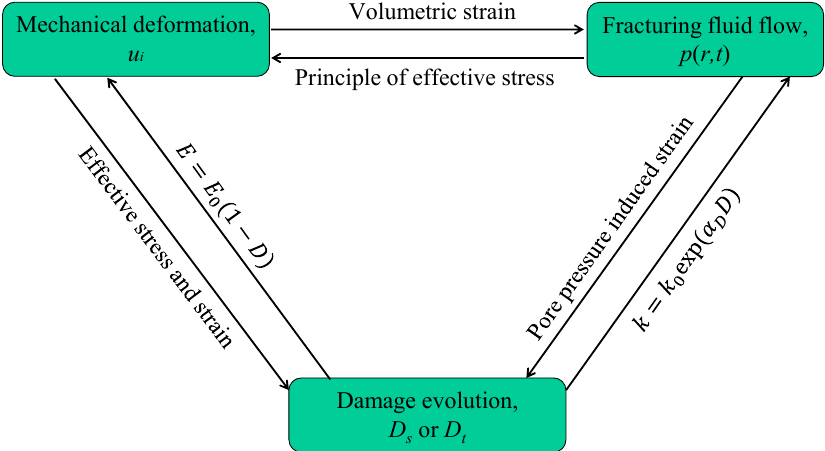
Figure 5. Interactions among mechanical deformation, fracturing fluid flow and damage evolution.